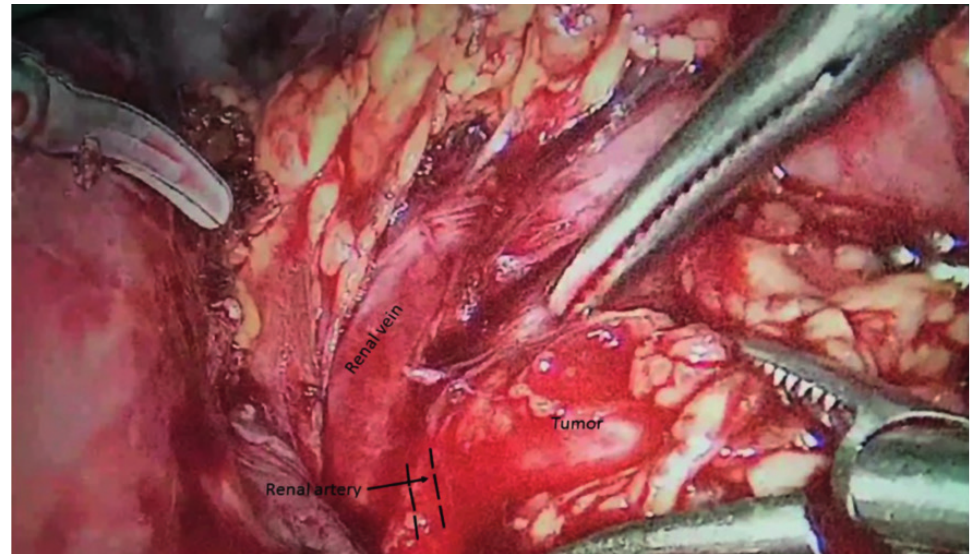
figure 2 - Laparoscopic transperitoneal tumor excision is shown. The tumor was adherent to the underlying renal